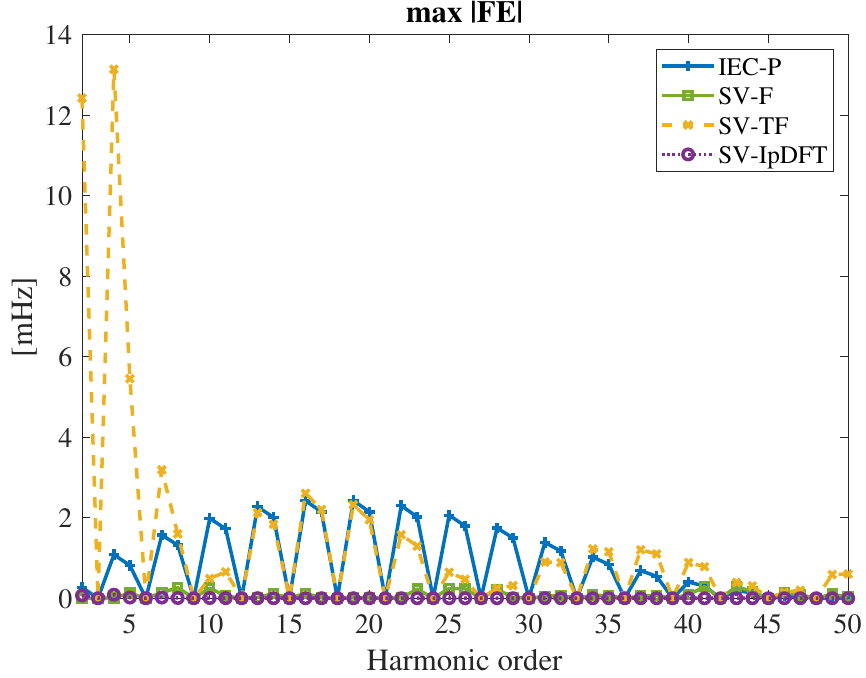
Figure 7. Maximum |FE| in the presence of 1% harmonic disturbances, f =